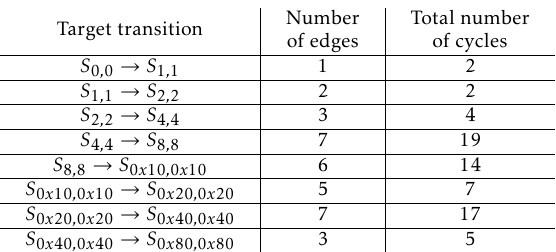
Algorithm 6: genqec : Generate q by considering context C